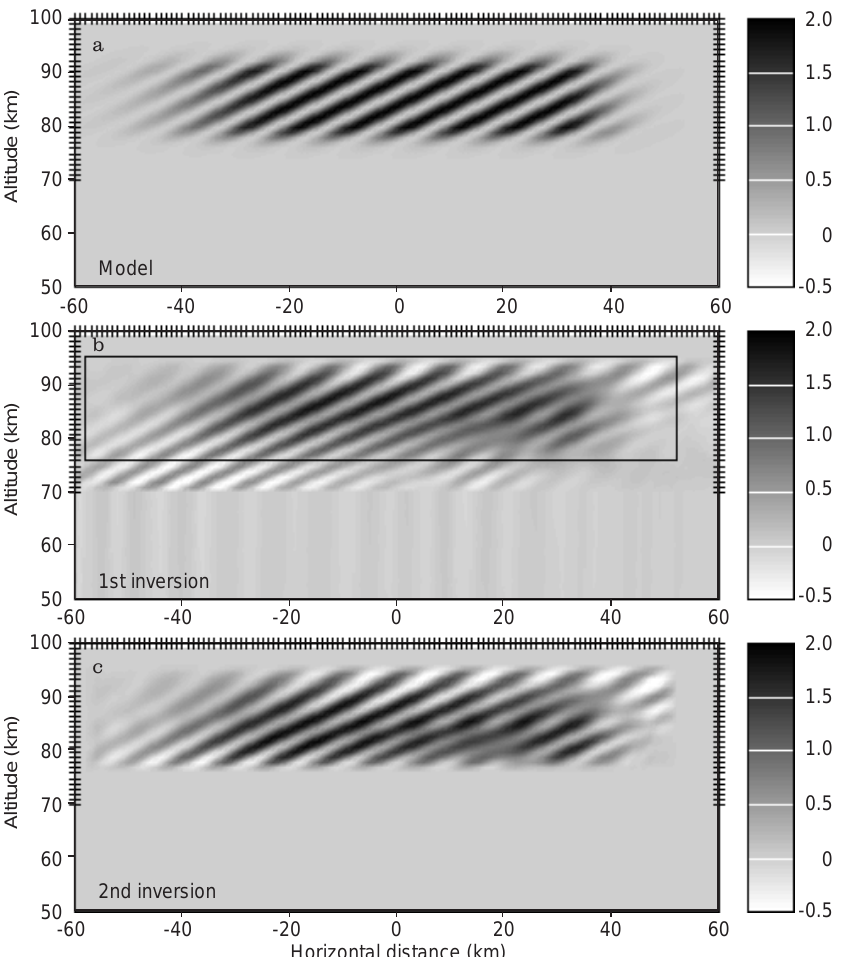
Fig. 8. Same as Fig. 3 with a thicker model layer. Here the wave amplitude is constant between 80 and 90 km and decreases with Gaussian scale heights of 2.5 km around this region. The wavelengths are the same as in